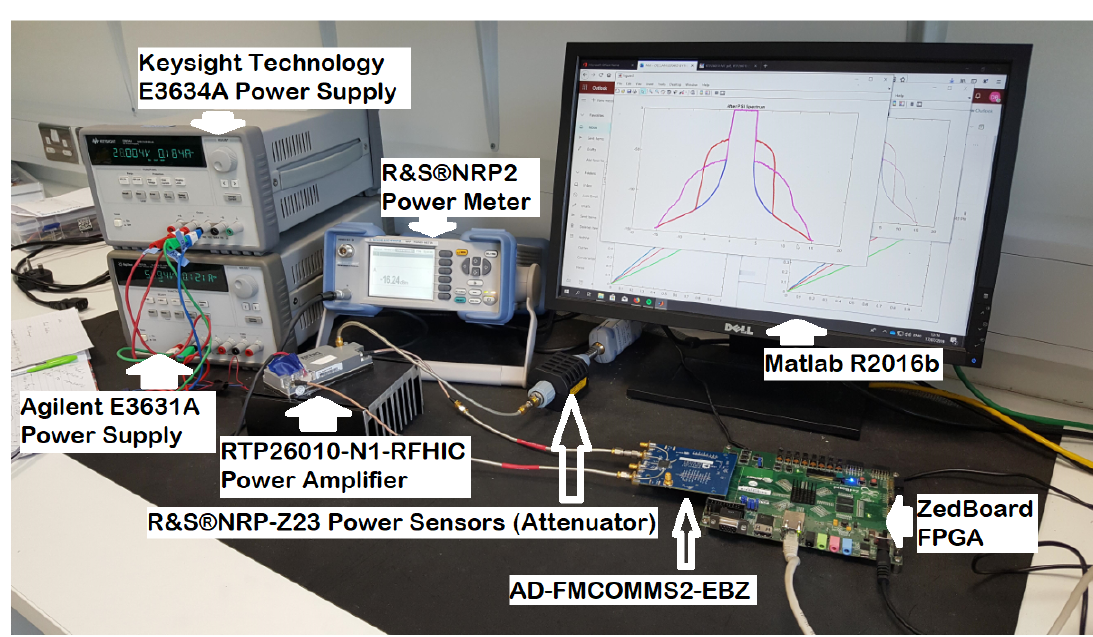
Figure 17. FPGA laboratory test bench set